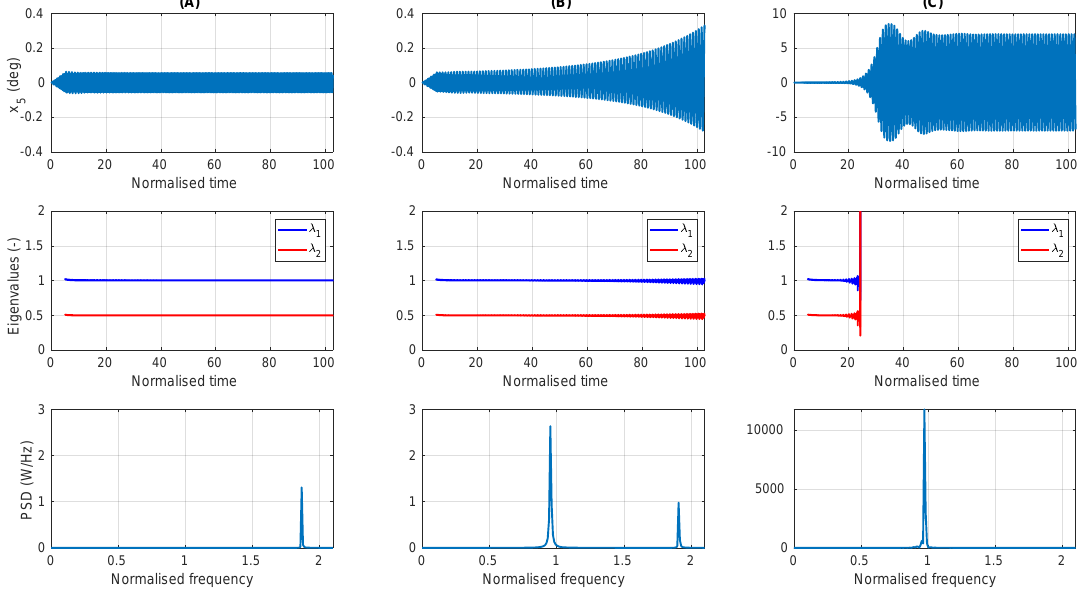
Figure 6. The performance of the early warning detection system in monochromatic waves; correct positives (white), correct negatives (grey), false positives (dark grey) and false negatives (black).